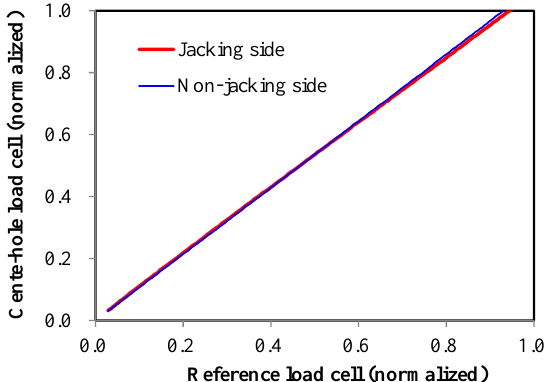
Figure 5. Relationship of the measurements between reference and center-hole load cells.